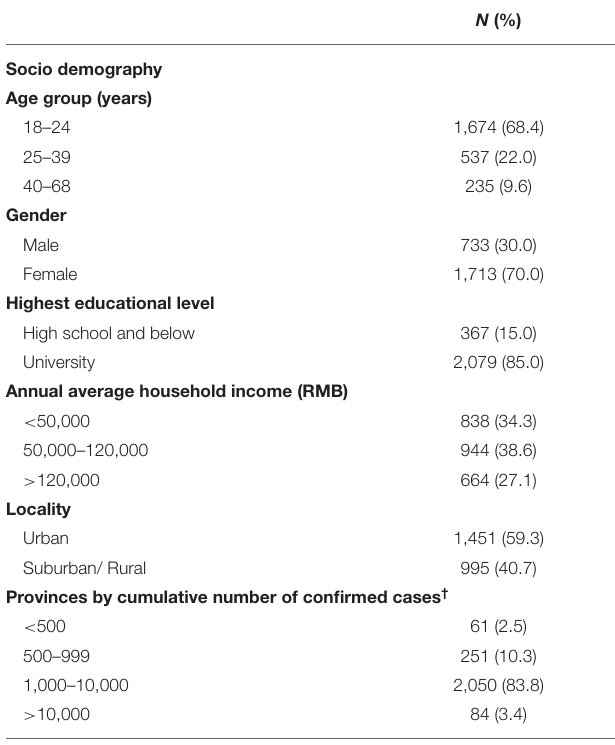
TABLE 1 | Demographic characteristics of respondents ( N =